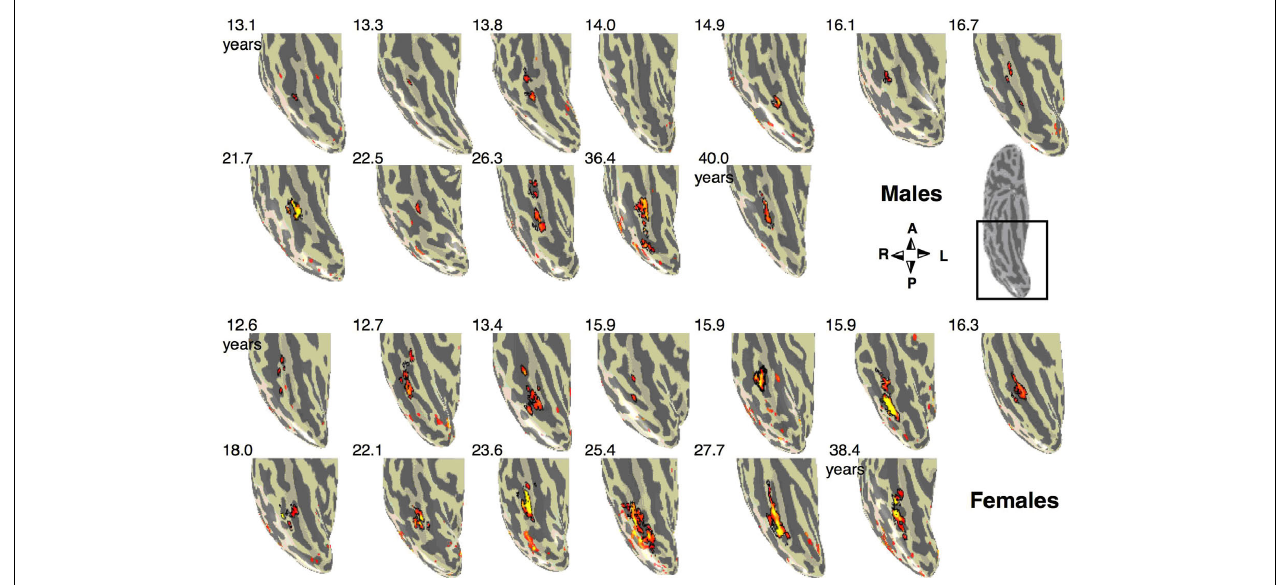
FIGURE 3 | Face selective activations in the right fusiform gyrus for each of the 25 subjects. Face selective activations for the contrast man and boy > cars and abstract objects, P < 10 –3 , uncorrected, are projected on the infl ated cortical surface of each individual from the right hemisphere for all subjects in the study. Brain images show the posterior aspect of the